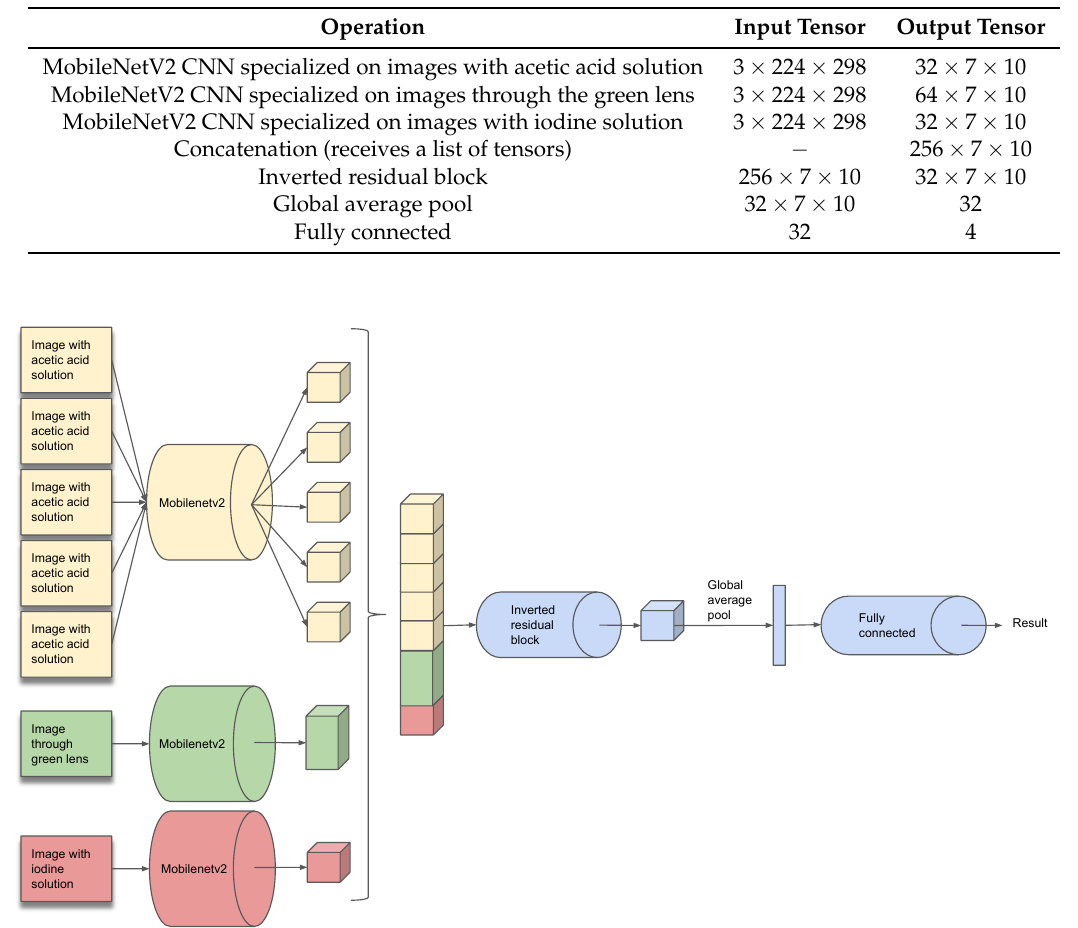
Table 3. Tensor sizes during a network run. The tensor sizes are displayed in the form: feature maps × height × width . The batch size is ignored.